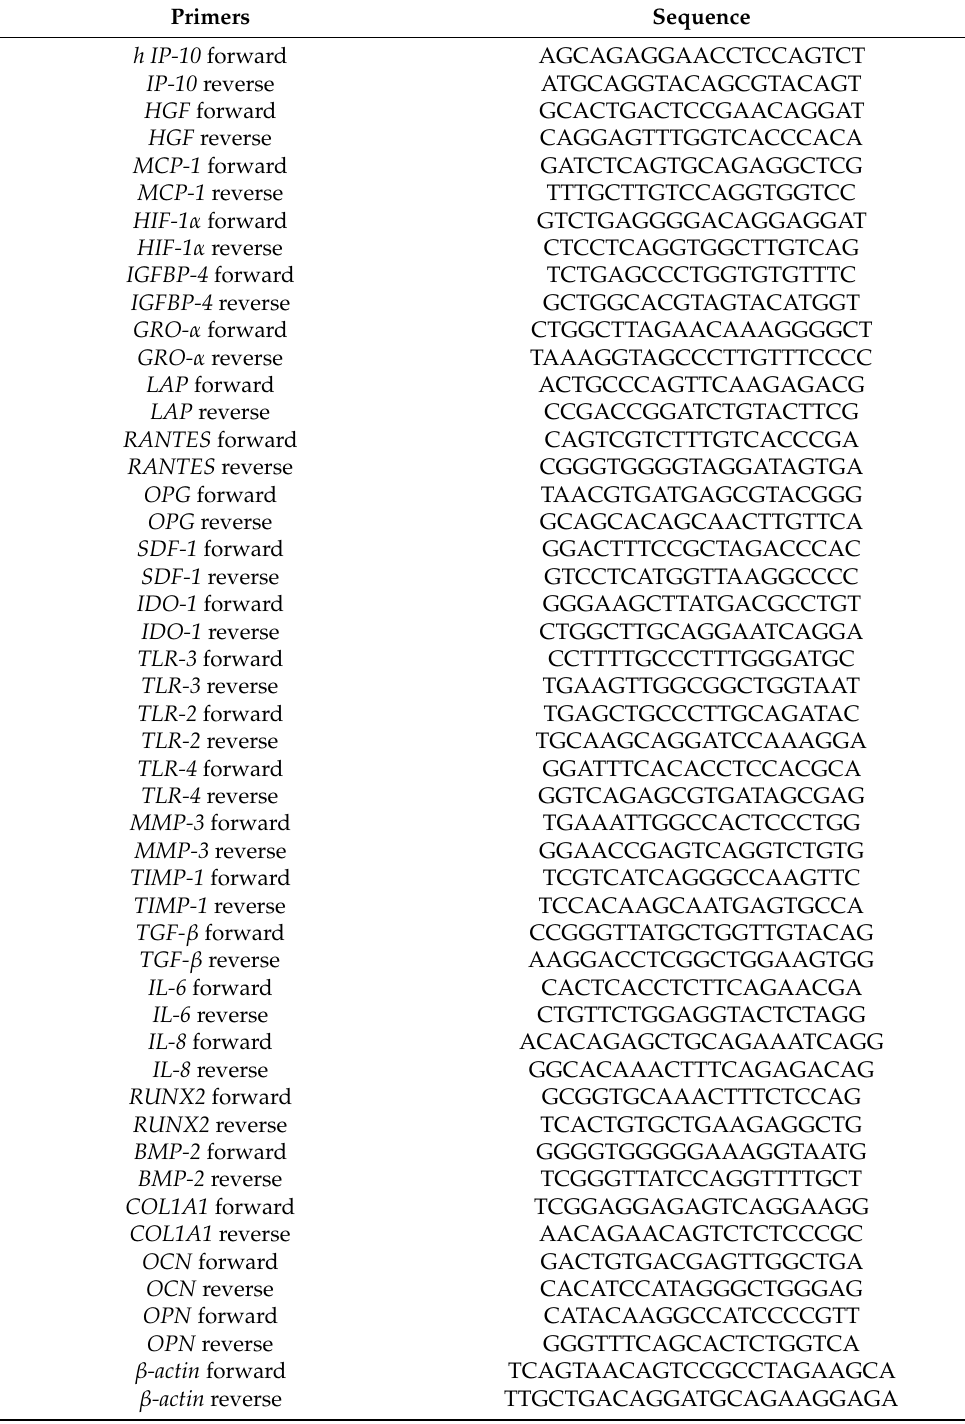
Table 1. Sequences of the primer pairs used for the real-time PCR